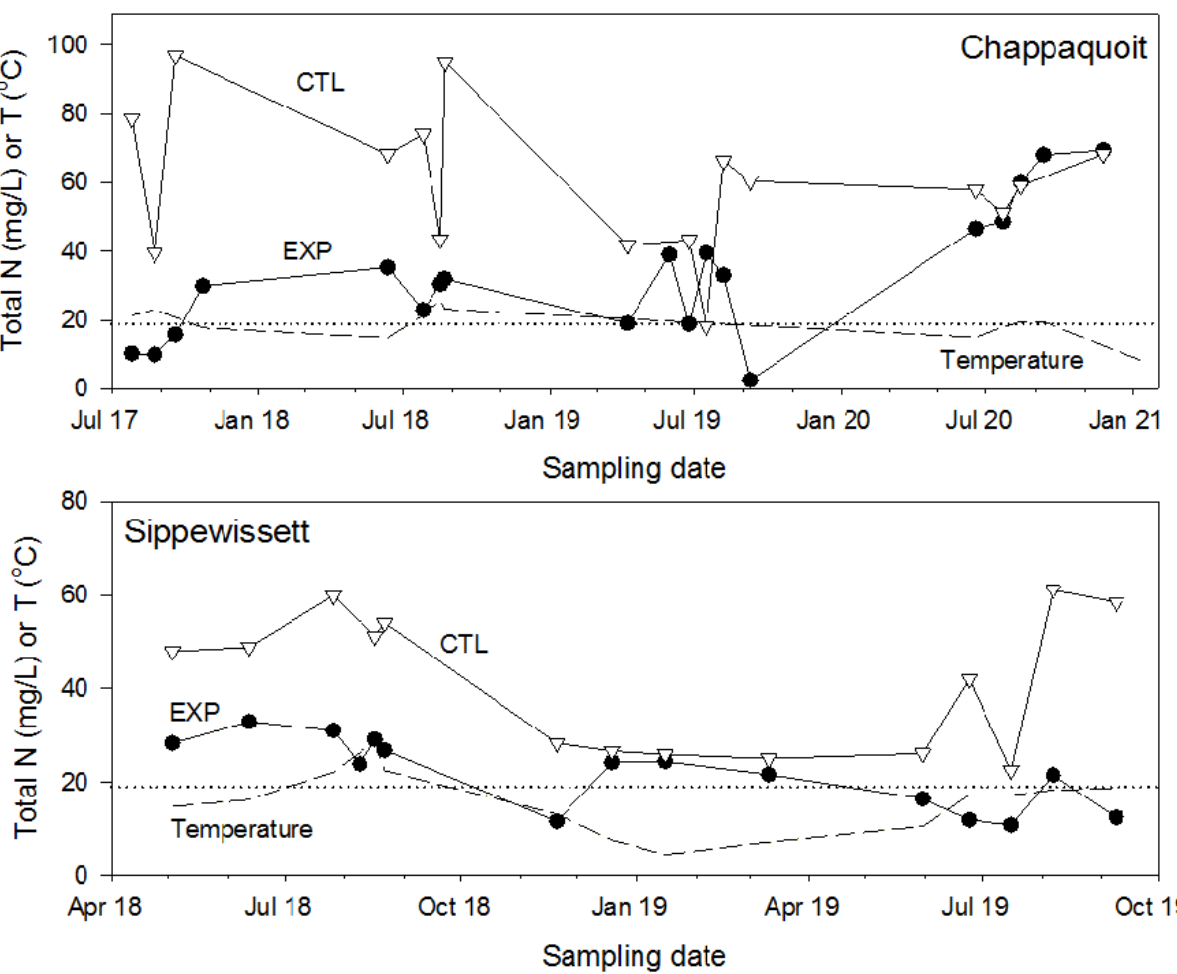
Figure 6. Total nitrogen concentration and temperature of effluent from the sawdust–amended (EXP) and unamended (CTL) sides of the soil treatment area for seasonally–occupied systems. Dotted line indicates 19 mg TN/L standard.